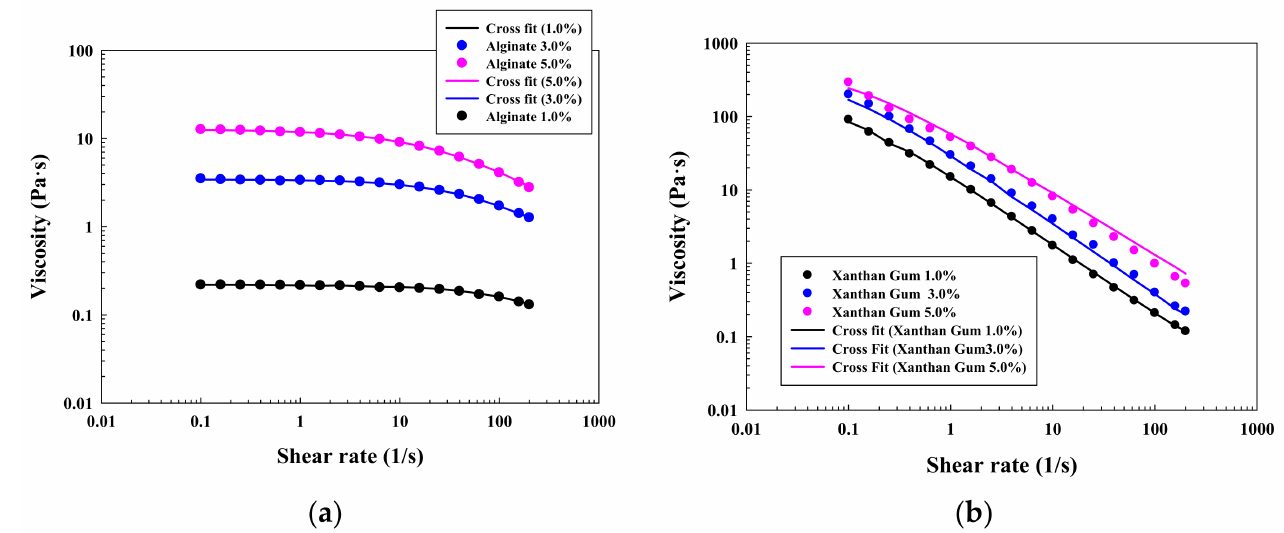
Figure 1. Shear stress-shear rate plots for solutions of ( a ) alginate; ( b ) xanthan